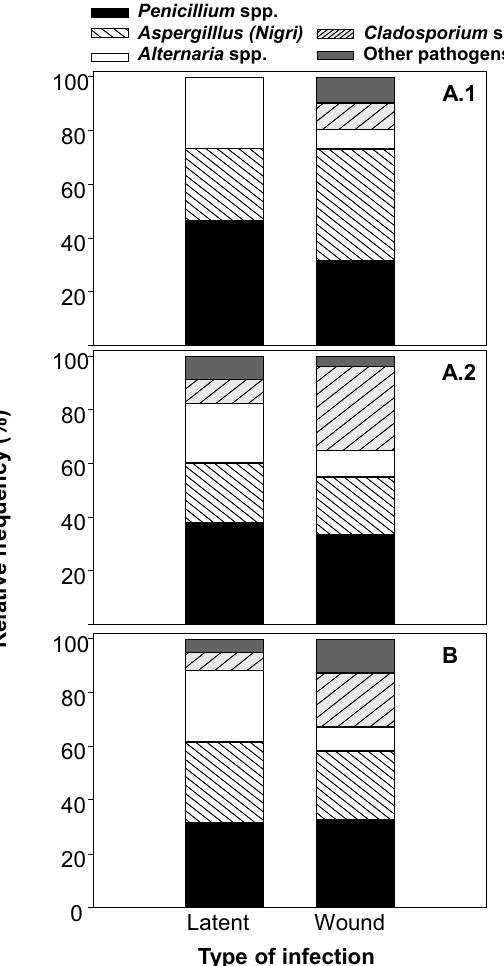
Figure 3 . Relative frequency of pathogens causing post- harvest diseases on date palm fruit ‘Boufeggous’ (A) for two consecutive seasons, 2006 (1) and 2007 (2) and ‘Med- jool’ for one season, 2007 (B). Date fruits were surface- disinfected (Latent) or artificially wounded (Wound) and incubated at 20ºC in humid chambers for 7 (A) or 3 weeks